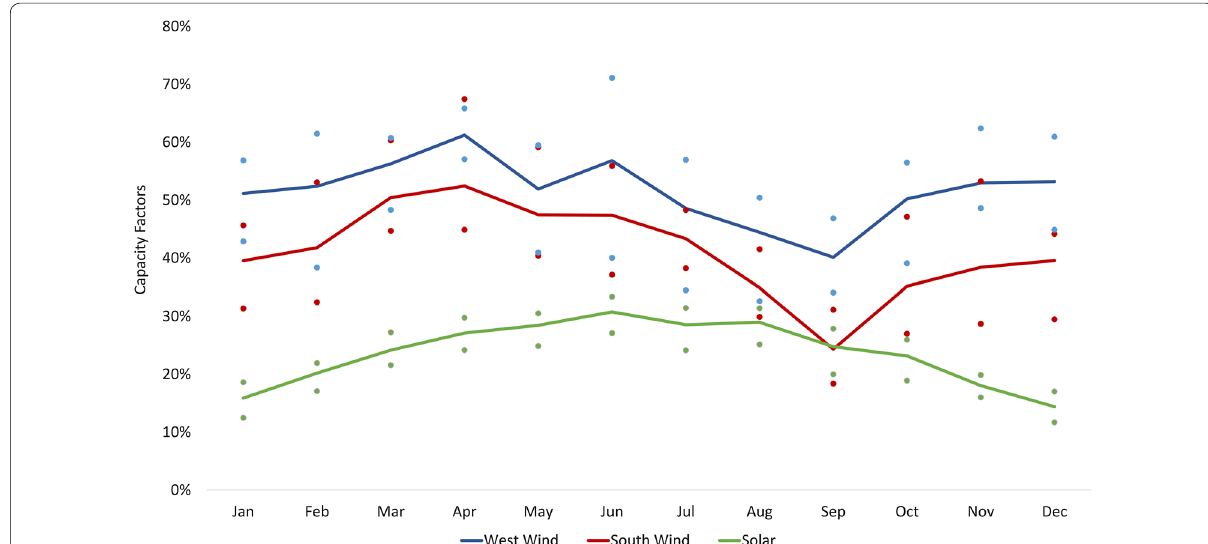
Fig. 3 Average monthly capacity factors for each resource type over the years 2007–2013. Circles display interannual minima and